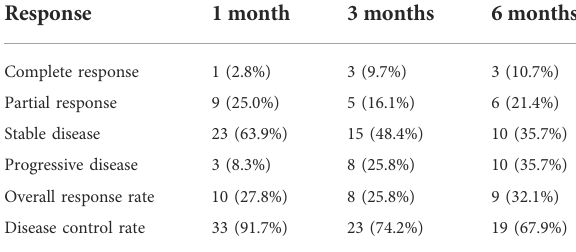
TABLE 3 Local tumor